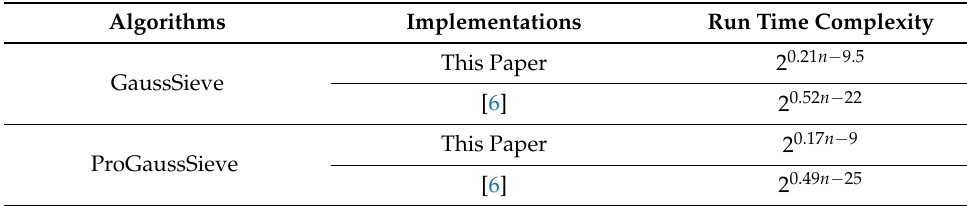
Table 3. The comparison of the run time complexities of the